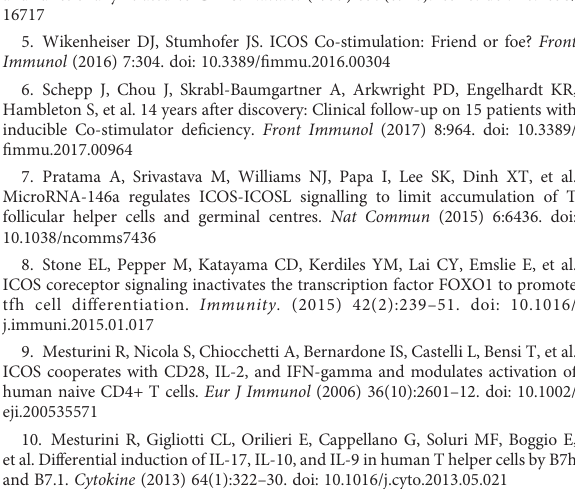
SUPPLEMENTARY FIGURE 2 Geneontology(GO)ofgenesassociatedwithICOSinCGGA325dataset. (A) GOin CGGA325 lower-grade glioma. (B) GOinCGGA325 glioblastoma. SUPPLEMENTARY FIGURE 3 Genesetenrichmentanalysis(GSEA)ofICOSinCGGA325dataset.(A)GSEAin CGGA325 lower-grade glioma. (B) GSEA in CGGA325 glioblastoma. SUPPLEMENTARY FIGURE 4 Correlation analysis between ICOS and other immune checkpoint members in CGGA325 dataset. (A) Correlation between ICOS and canonical immune checkpoints in lower-grade glioma. (B) Correlation between ICOS and canonical immune checkpoints in glioblastoma. (C) Correlation between ICOS and additional immune checkpoints in lower- grade glioma. (D) Correlation between ICOS and additional immune checkpoints in glioblastoma. SUPPLEMENTARY FIGURE 5 Correlation analysis between ICOS and additional immune checkpoints in CGGA301 and TCGA datasets. (A) Correlation analysis in CGGA301 dataset. (B) Correlation analysis in TCGA lower-grade glioma. (C) Correlation analysis in CGGA301 glioblastoma. (D) Correlation analysis in TCGA glioblastoma. SUPPLEMENTARY FIGURE 6